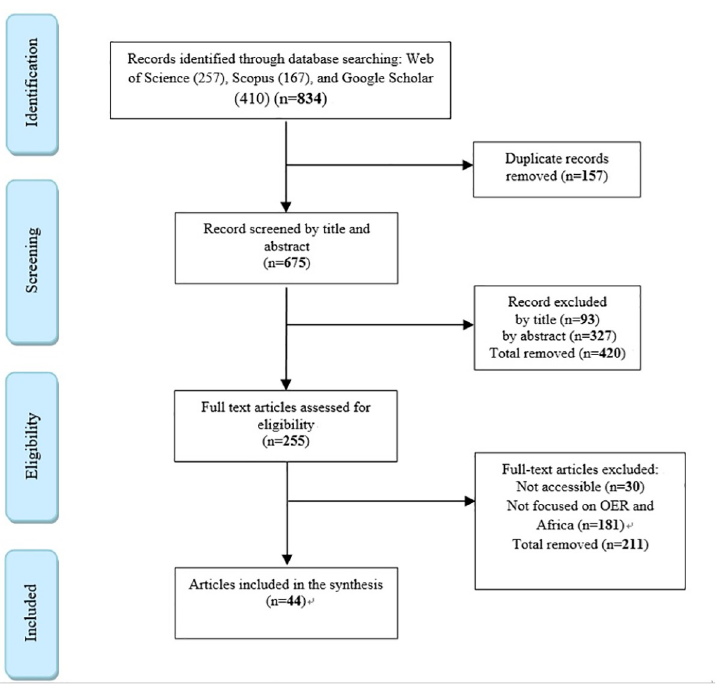
Fig 1. Flowchart of the systematic review